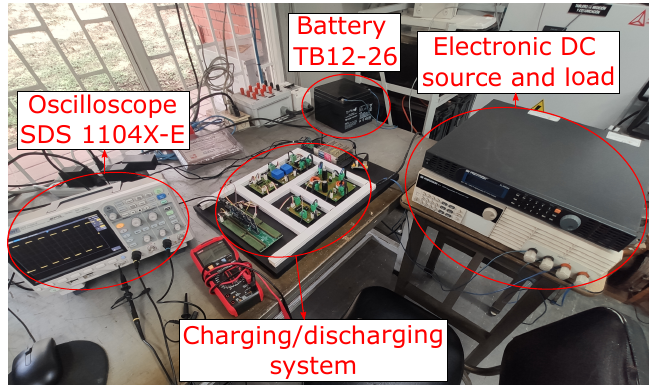
Figure 22. Experimental